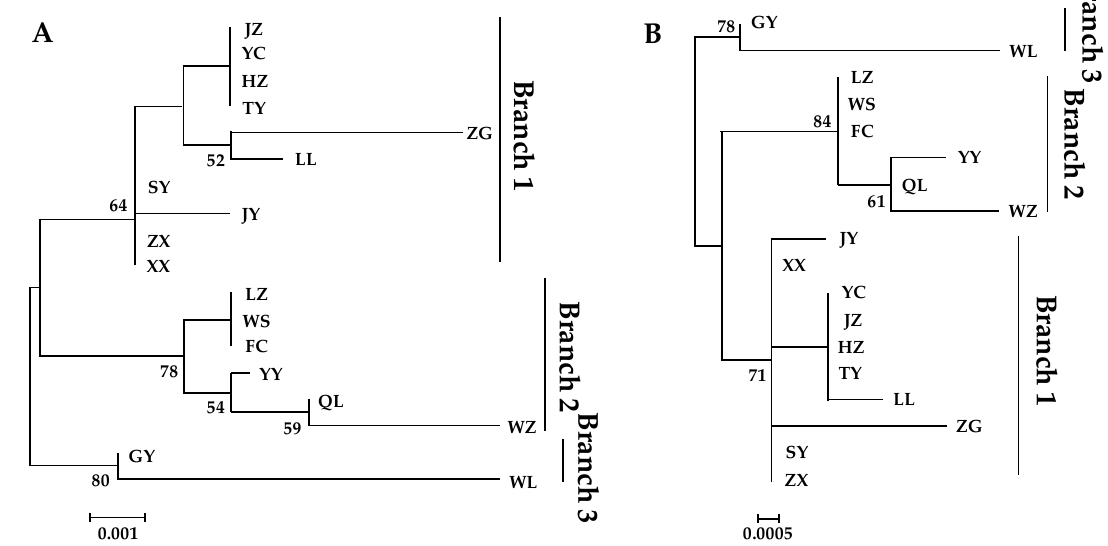
Figure 2. Phylogenetic analyses of nad4 sequence from 18 Bactrocera minax populations. ( A ) Phylogenetic tree of nad4 sequence using the neighbor-joining method estimated with MEGA v. 5.05. ( B ) Phylogenetic tree of nad4 sequence using the maximum-likelihood method estimated with PhyML v. 3.0. Bootstrap value was indicated at each node.